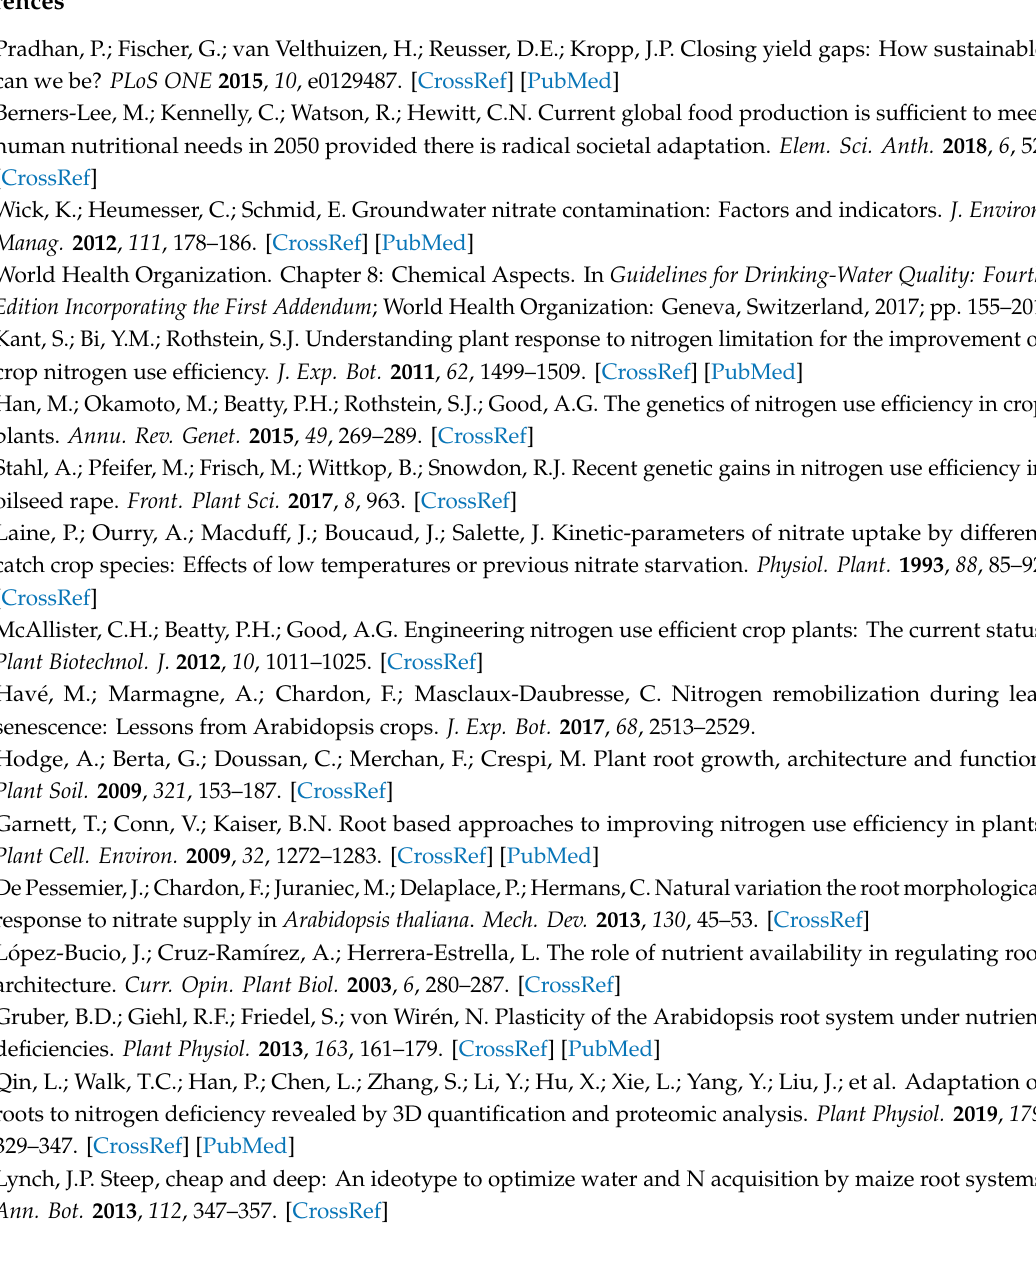
Figure S1: Root morphologies of three oilseed rape cultivars cultivated in hydroponics, Figure S2: Global ANOVA of measured traits at di ff erent periods in field experiment, Table S1: Root system parameters of three oilseed rape cultivars cultivated in hydroponics, Table S2: Pearson’s correlation coe ffi cients between parameters measured at di ff erent time